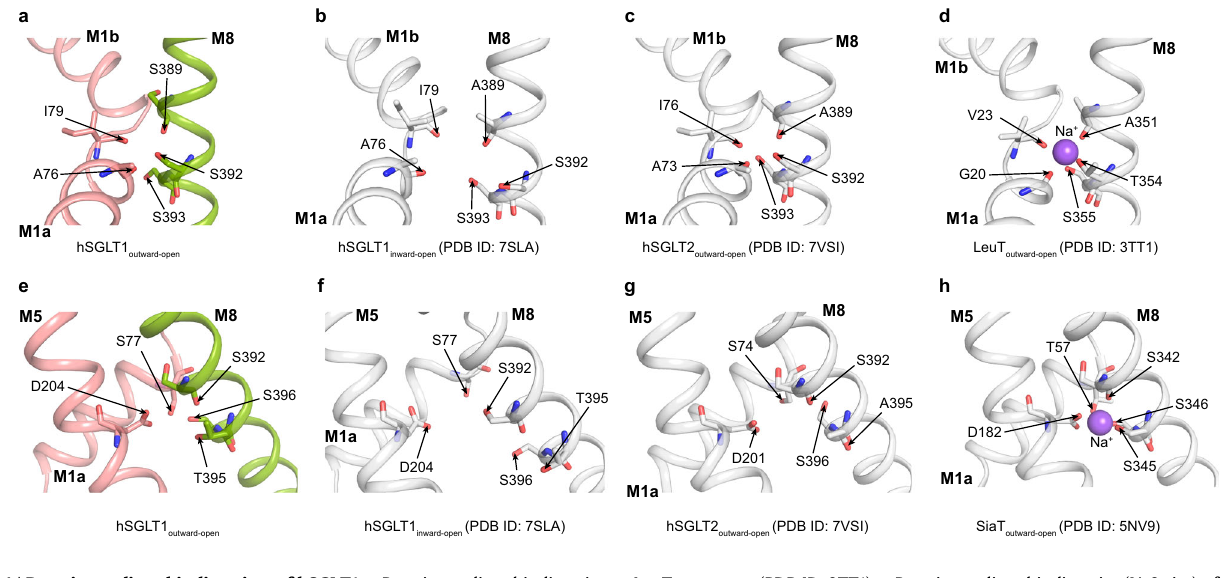
LeuT outward-open (PDB ID: 3TT1). e Putative sodium-binding site (Na3 site) of hSGLT1 outward-open . f Putative sodium-binding site (Na3 site) of hSGLT1 inward-open . g Putative sodium-binding relative site (Na3 site) of hSGLT2 outward-open . h Putative sodium-binding site (Na3 site) of SiaT outward-oepn (PDB ID: